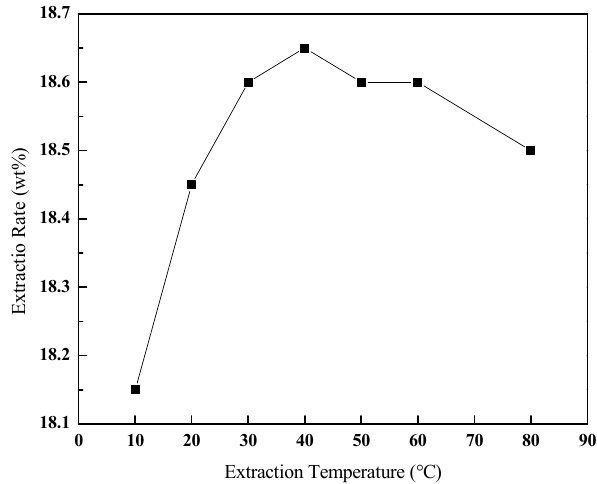
Figure 6. Effect of the temperature on the extraction rate of bitumen. Figure 6. E ff ect of the temperature on the extraction rate of bitumen.